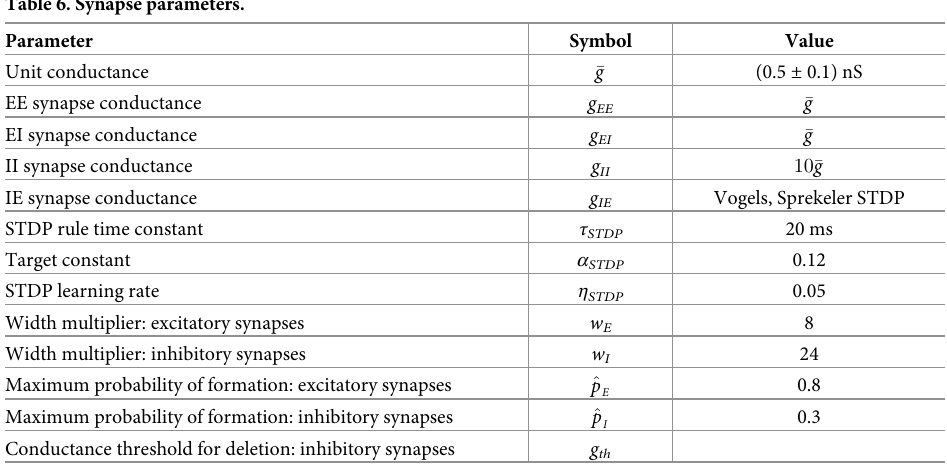
Table 6. Synapse